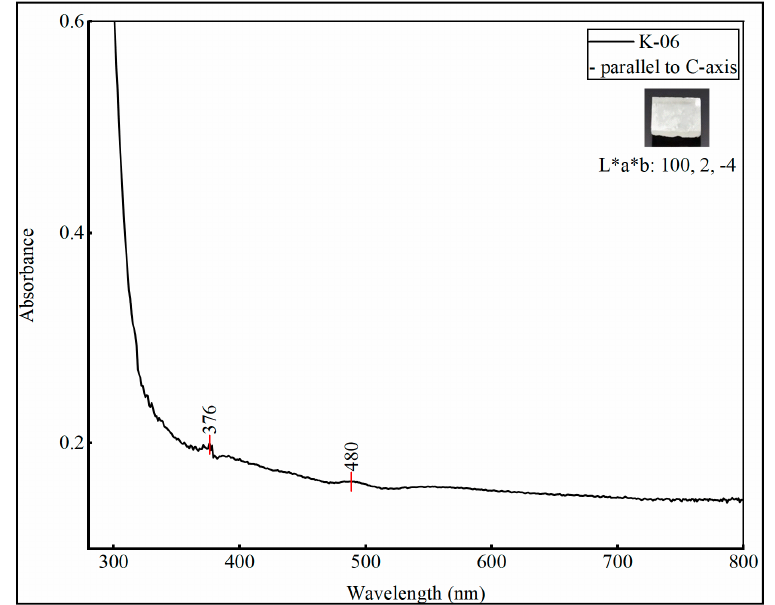
Figure 6. The graph shows the UV − visible spectrum of sample K-06, whose color is totally white and only shows a little absorbance due to Fe when measured along the C-axis. Color coordinates (CIE L*a*b) were taken by using uvwinlab \ meth900 and D65 illuminant in transmission mode.